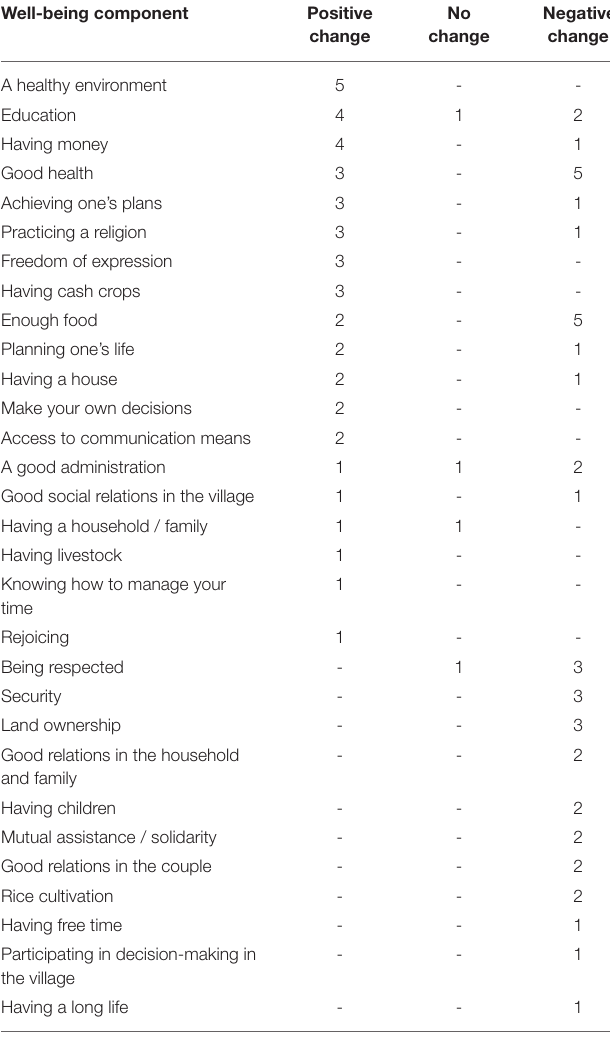
TABLE 6 | Change in satisfaction with well-being components. Well-being